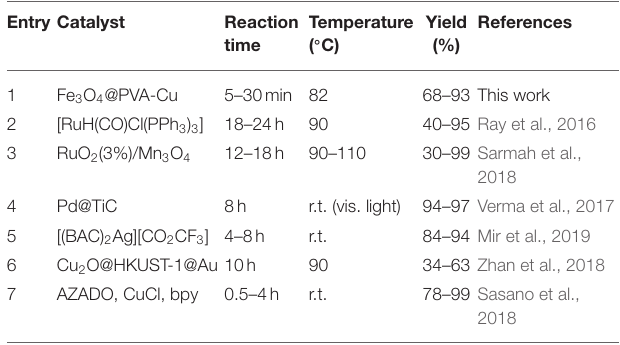
TABLE 1 | Comparison of previously reported catalysts for oxidation of alcohols to aldehydes and